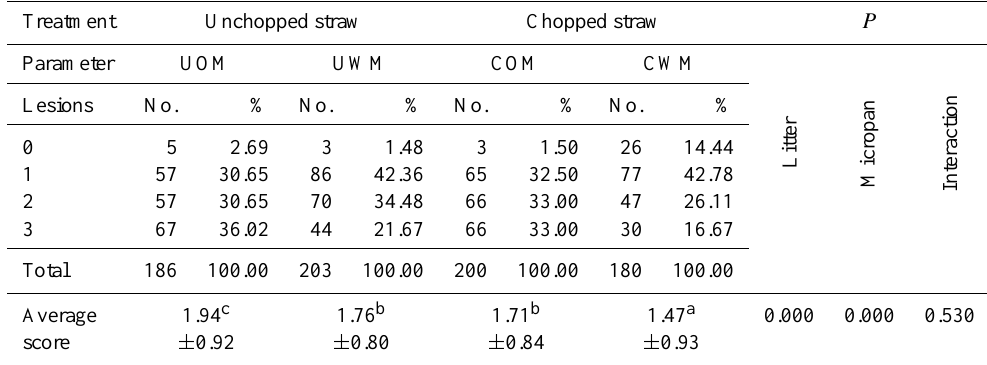
on Lesions No. % No. % No. % No. % n ti r op a ac itt e c r L e r M i n t I